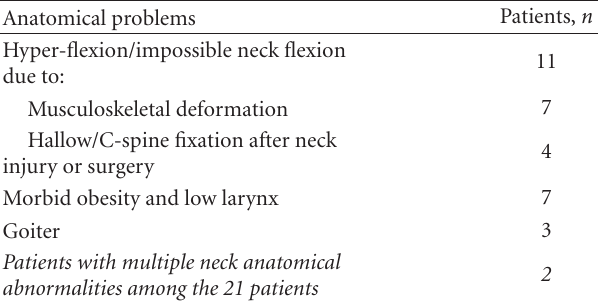
Table 1: Description of the local anatomical problems in our